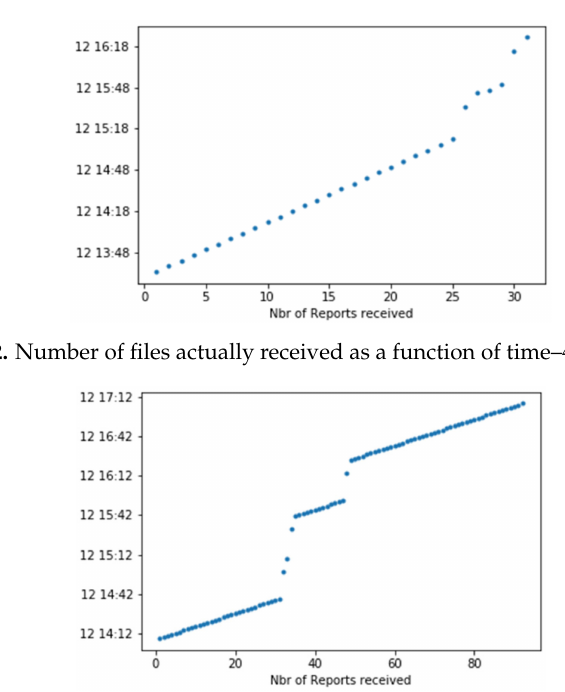
Figure 11. Number of files actually received as a function of time–6 smart meters.